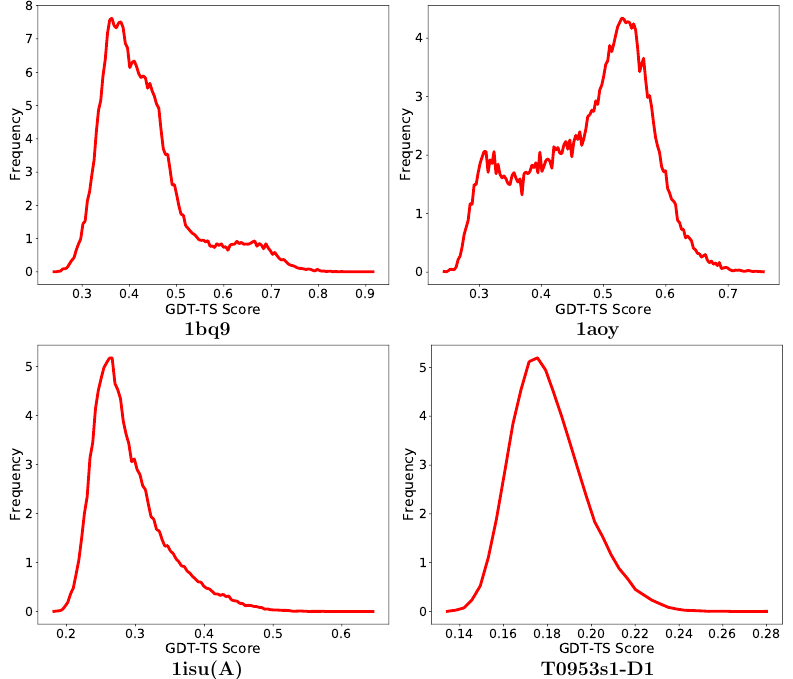
Figure 4. Distribution of global distance test-total score scores for one medium difficulty protein under PDB entry 1bq9, two hard proteins under PDB entries 1aoy and 1isu(A) from the non-CASP targets and T0953s1D1 from the CASP targets. The x -axis tracks GDT-TS scores. The y -axis tracks frequency of decoys with corresponding GDT-TS scores. The frequency has been scaled to a range [1–10] by dividing all frequencies by the minimum